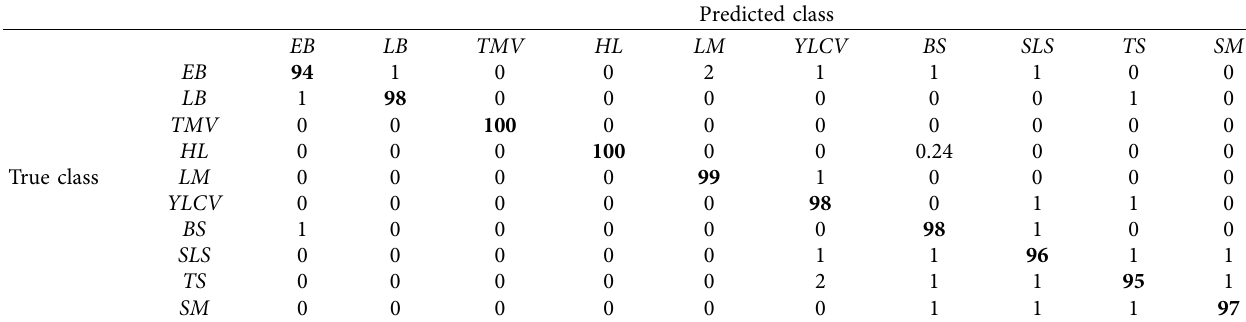
Table 6: Reported confusion matrix for tomato plant diseases recognition with proposed SLS-based method.